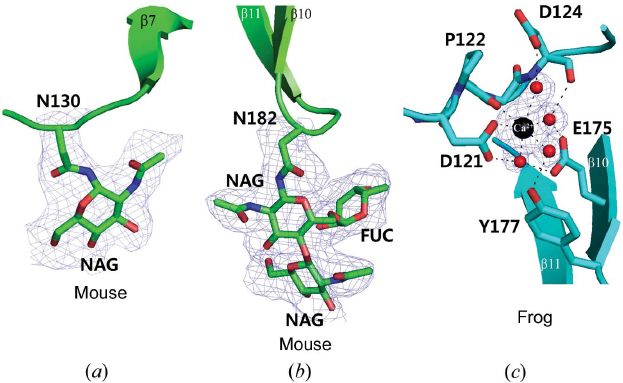
Figure 3 Views of the asparagine residues with glycosylations (in mouse EPDR1) ( a , b ) and the Ca 2+ -binding site (in frog EPDR1) ( c ) with experimental electron densities. ( a ) In mouse EPDR1, Asn130 is clearly seen to have a NAG modification. A stimulated-annealing OMIT map of F o (cid:3) F c difference density was contoured at 1.1 (cid:6) . ( b ) Also in mouse EPDR1, Asn182 is clearly seen to have a NAG–FUC–NAG modification. A stimulated-annealing OMIT map of F o (cid:3) F c difference density was contoured at 1.1 (cid:6) . ( c ) In frog EPDR1, Ca 2+ was found to be octahedrally coordinated by four water molecules and other nearby atoms of Asp121 and Pro122. The water molecules coordinated to Ca 2+ are further stabilized by tight hydrogen-bonding interactions with the nearby residues Asp124, Glu175 and Tyr177. A stimulated-annealing OMIT map of F o (cid:3) F c difference density was contoured at 3.0 (cid:6)